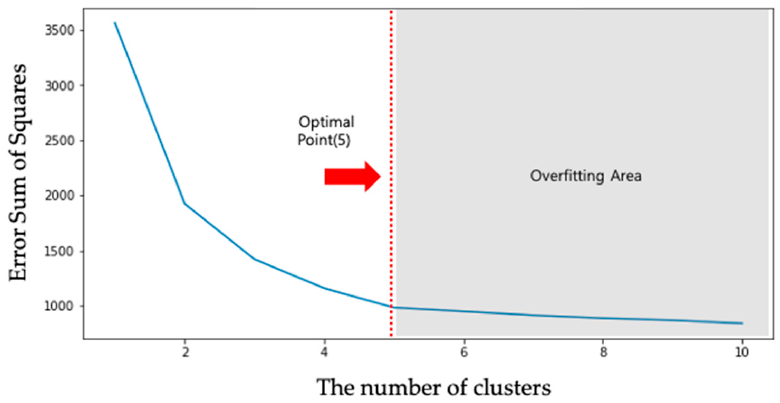
Figure 3. Sum of squares error (SSE) of residential customers clustered using K-means and elbow method.